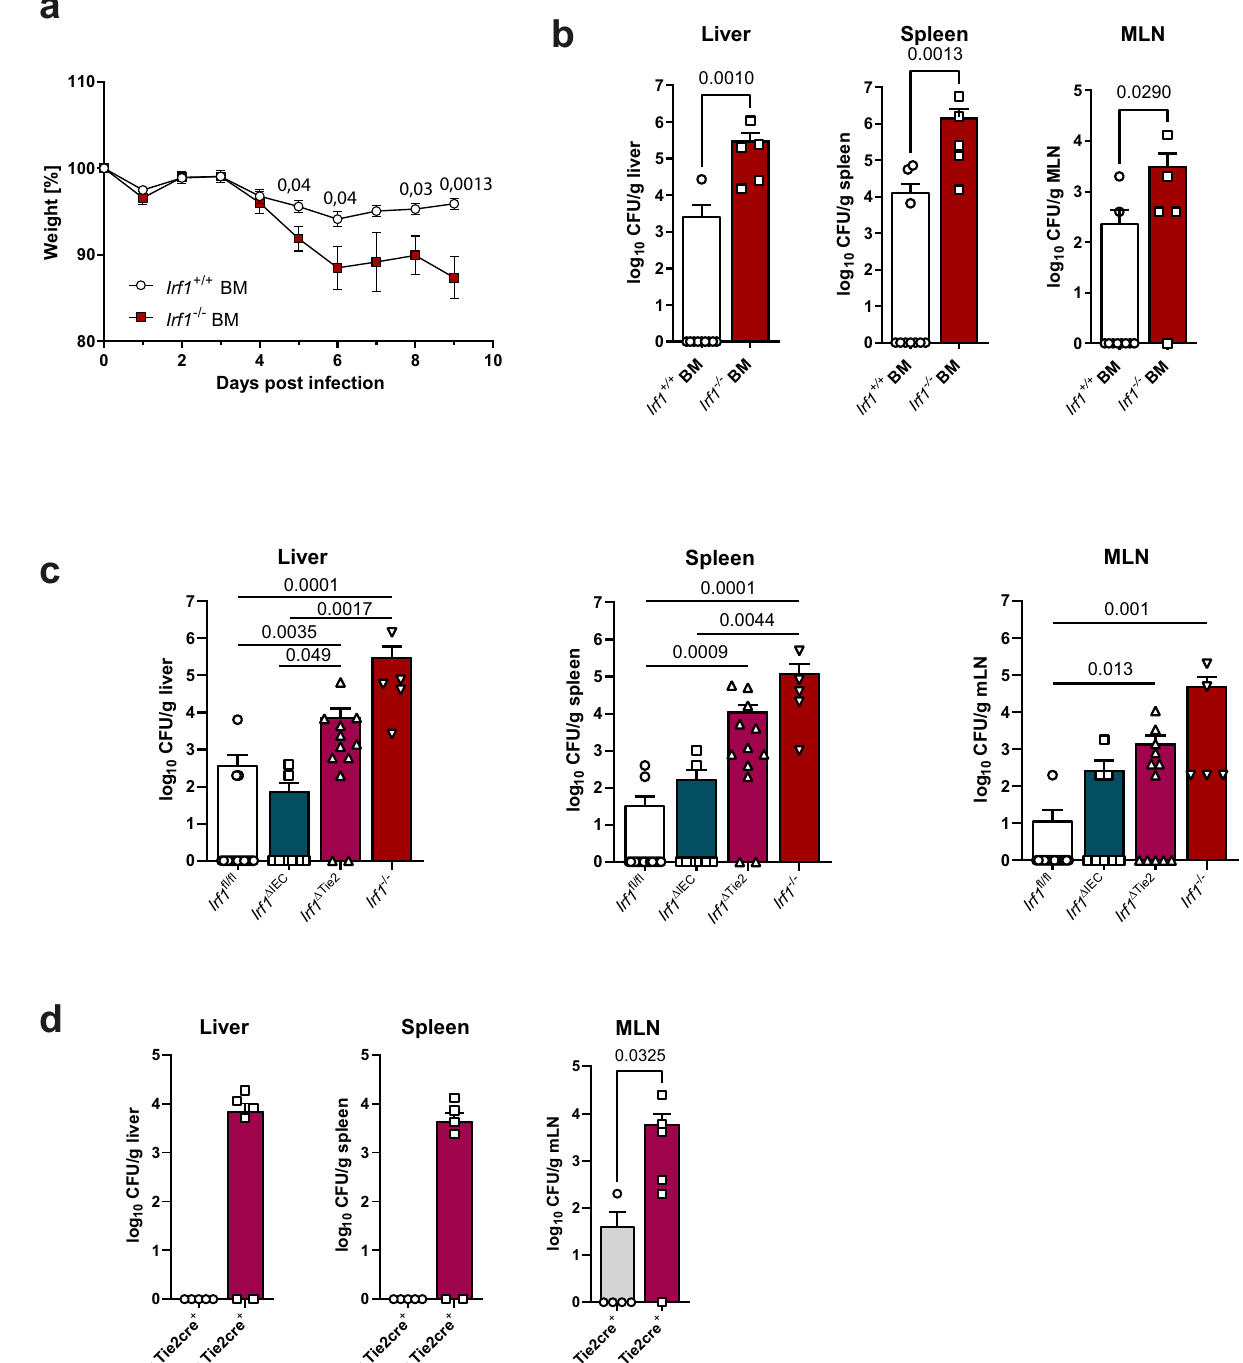
Fig. 3 | IRF-1 expression is required in hematopoietic cells during C. rodentium infection. a , b Chimeric mice were generated by reconstitution of irradiated C57BL/6 mice with Irf1 +/+ or Irf1 – / – bone marrow. 8 weeks later, chimeras were infected with C. rodentium and analyzed 9 dpi. a Weights are shown as percentage of baseline ( Irf1 +/+ BM: n =13, Irf1 – / – BM: n =11). b C. rodentium dissemination to livers, spleens and mLNs. ( Irf1 +/+ BM: n =10, Irf1 – / – BM: n =5). c Irf1 – / – , Irf1 Δ Tie2 and Irf1 Δ IEC mice were infected with C. rodentium and compared to Irf1 fl / fl mice. ( Irf1 Δ Tie2 :